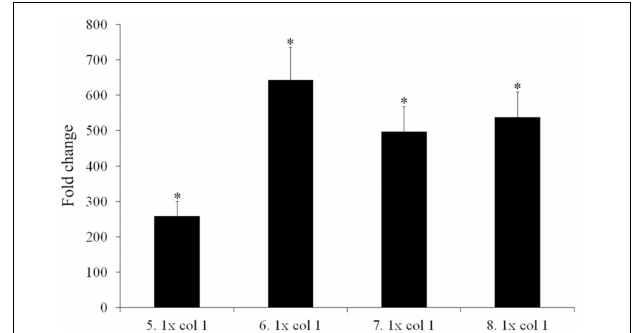
FIGURE 4 | mexC over-expression in tigecycline evolved individual clones. Four individual clones from the tigecycline evolved populations after 5 days of the experiment were isolated. The presence of the different nfxB mutations, as well as the absence of orfN mutations, were addressed. Fold changes were estimated with respect to the value given by P. aeruginosa PA14 strain. Error bars indicate standard deviations of the results from three independent experiments. Statistically significant differences ( p < 0.05) in the level of expression of each population with respect to the wild type strain was evaluated using the Student’s T -test and are highlighted with asterisks. 5.1–8.1: clones isolated from the populations evolved under tigecycline selective pressure at day five of